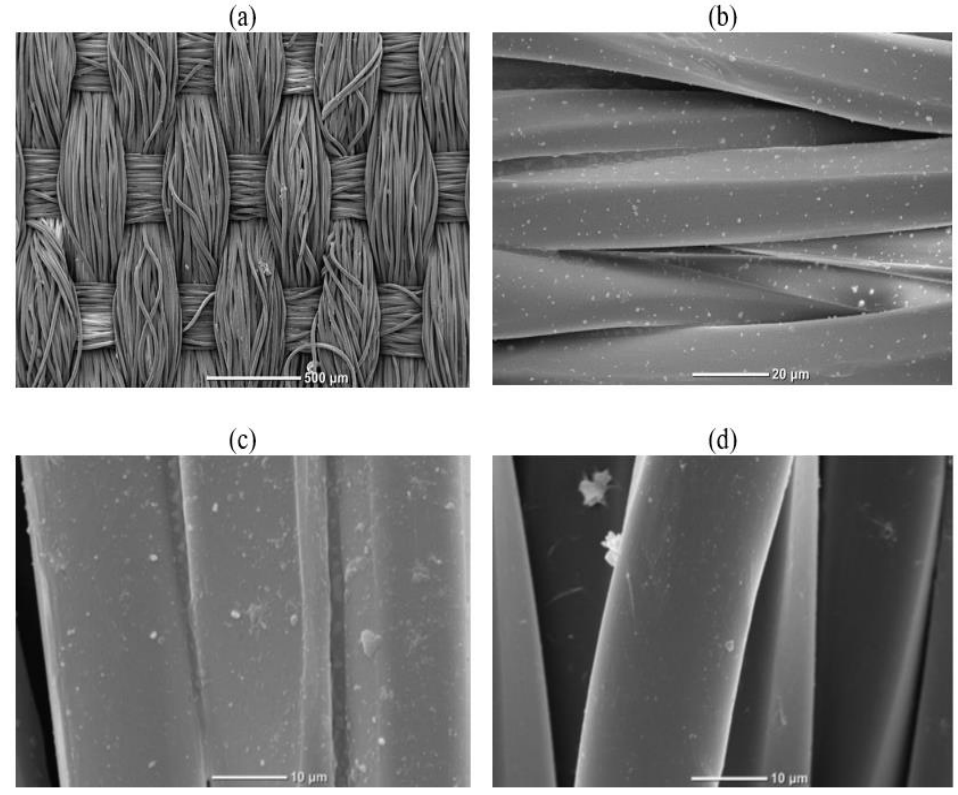
Figure 3. SEM images of P-PET ( a ) and P — PET — G ( b – d ): Visualization of the oil distribution on polyester fabrics.